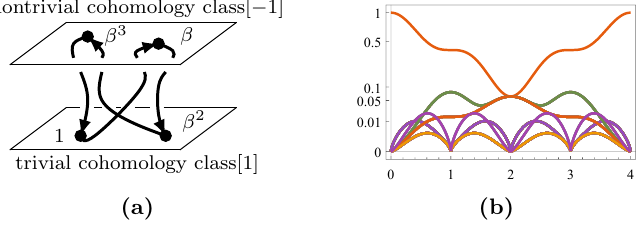
Figure 2. (a) Parameter space for the Hamiltonian deformation. Hamiltonian H depends on (cid:12) t that goes along a path in the 2-cochain space. The path starts at (cid:12) = 1 at t = 0, goes through a nontrivial 2-cocycle (cid:12) at t = 1, then (cid:12) 2 2 [1] (but not identical to 1) at t = 2, and another nontrivial 2-cocycle (cid:12) 3 at t = 3, and goes back to (cid:12) 4 = 1 at t = 4. (b) Variation of j C j 1 ;:::;j N along the deformation passage for N =